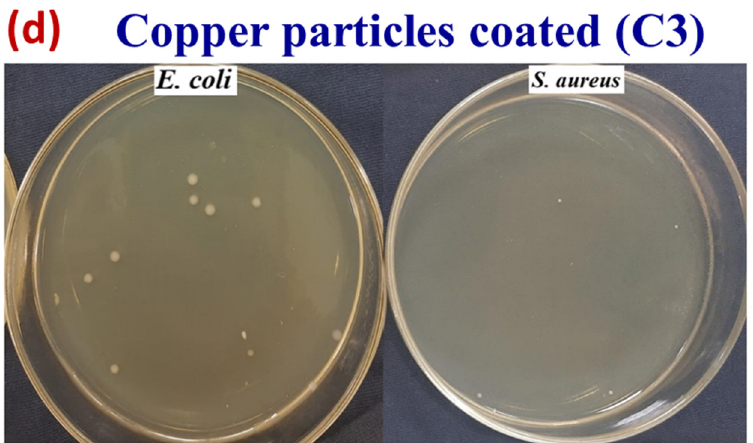
Figure 15. Images of concentration of bacterial growth for the ( a ) untreated (pristine) cotton fabric, ( b ) for phytochemicals, ( c ) for silver particles, and ( d ) for copper particles.